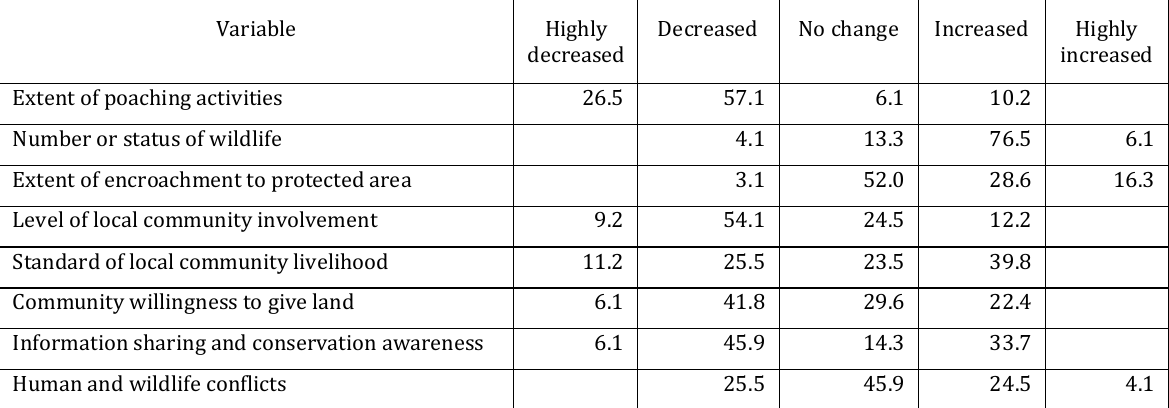
Table 3. Community participation in wildlife cnonservation (%)